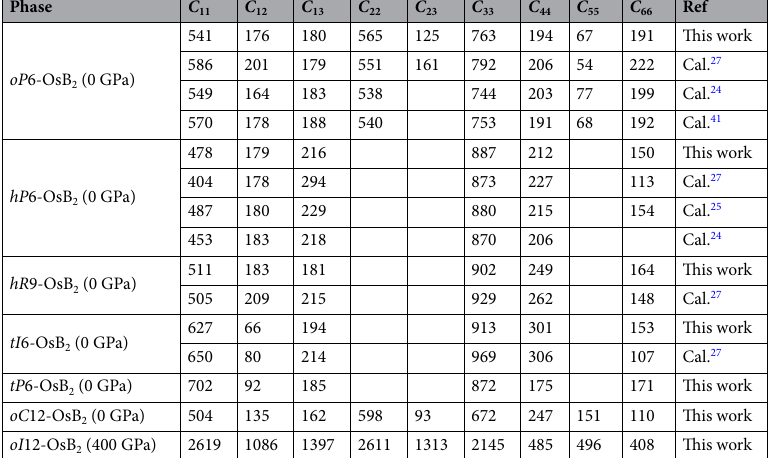
Table 2. Calculated elastic constants C ij (in GPa) of different OsB 2 structures, together with other theoretical